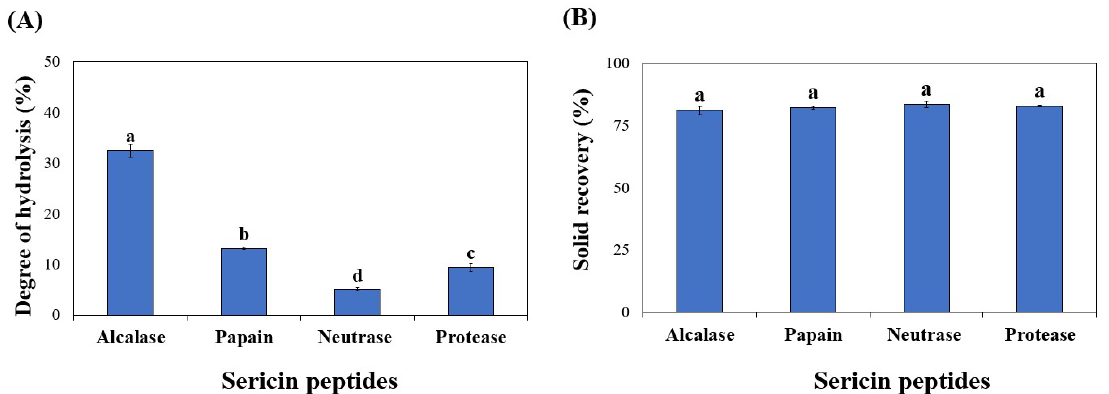
Figure 1. Degree of hydrolysis ( A ) and solid recovery ( B ) of sericin hydrolyzed for 4 h with different commercial enzymes. Significantly different values ( p < 0.05) are represented by superscript letters (a–d).